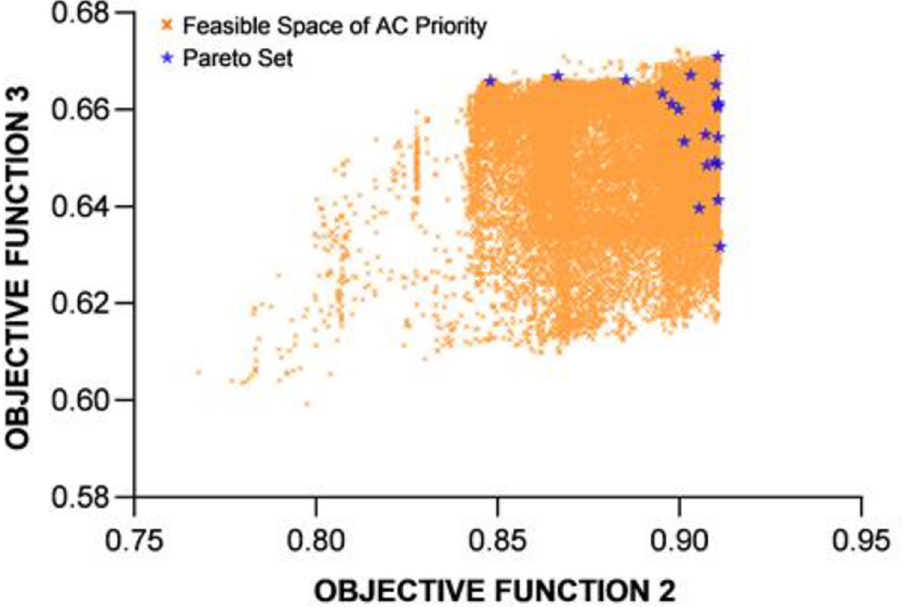
Fig 14. The profile of feasible solutions under the 21 scenarios and the Pareto set for the two objective functions under the AC priority operation mode.